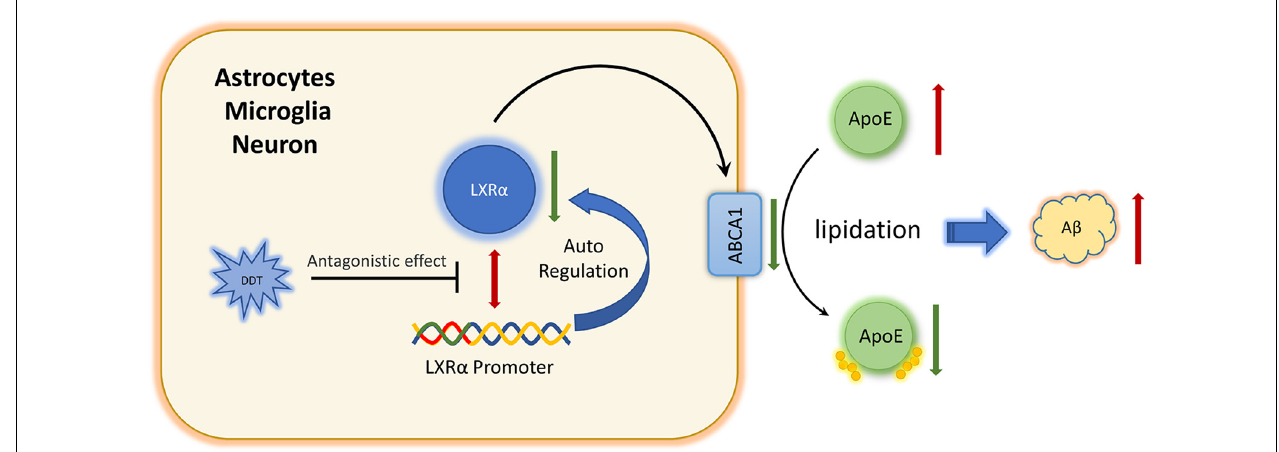
FIGURE 6 | Schematic diagram of DDT impairs amyloid beta (A β ) clearance via antagonizing LXR α